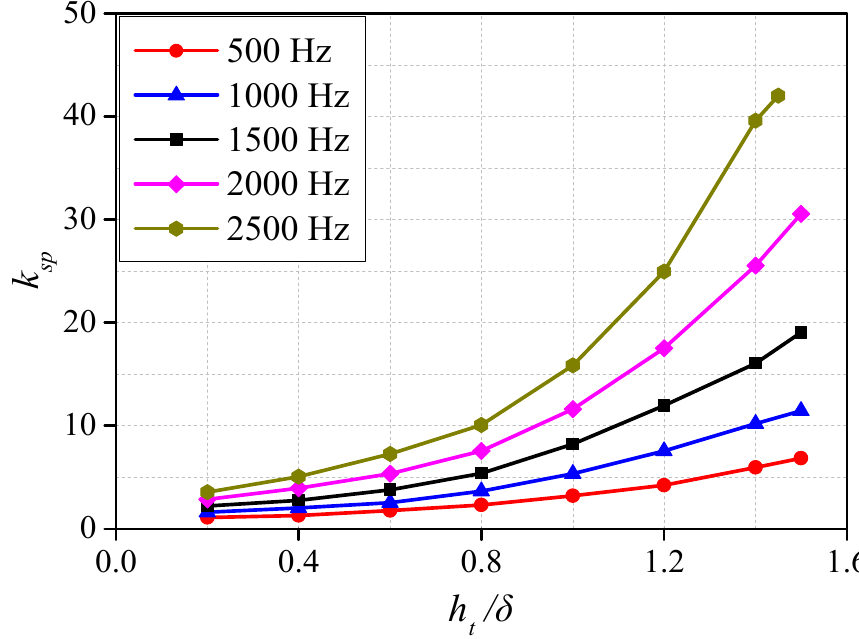
Figure 8. k sp versus ratio of wire thickness to skin depth at different frequencies.